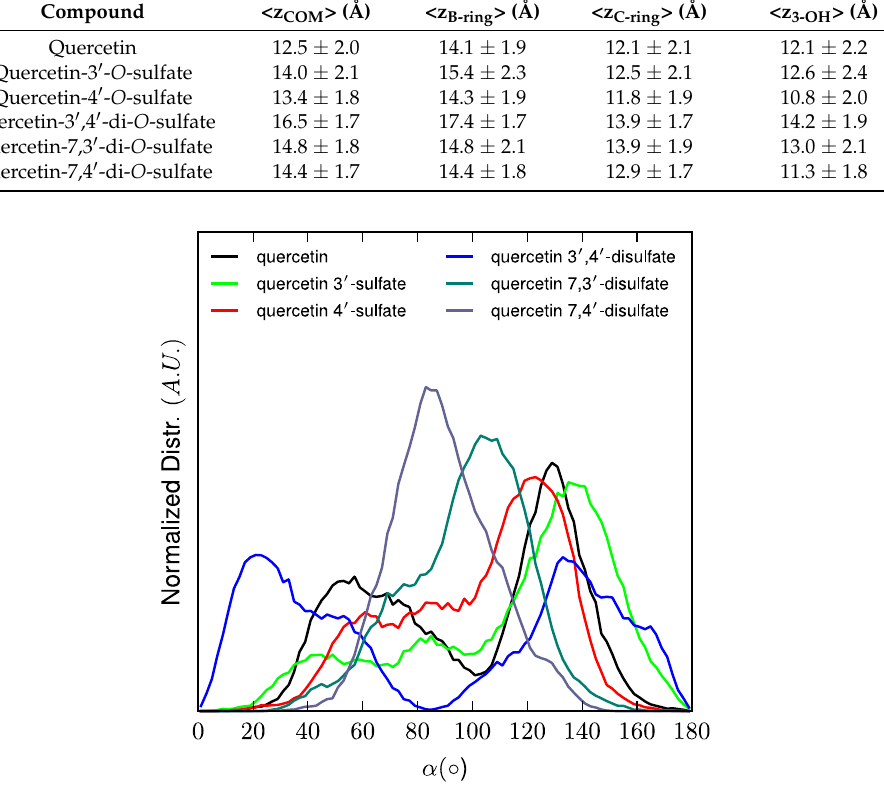
Figure 5. Normalized distribution of the orientation of quercetin derivatives with respect to membrane normal axis (z) pictured by the α -angle.